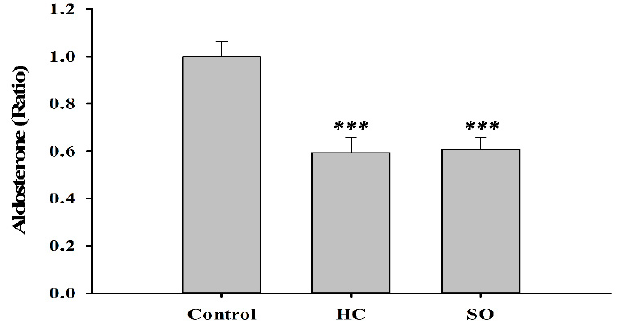
Figure 8. Aldosterone level in T2DM model rats after 28 days of treatment. Significant difference between the control-treated group at *** p < 0.001 by one-way ANOVA.